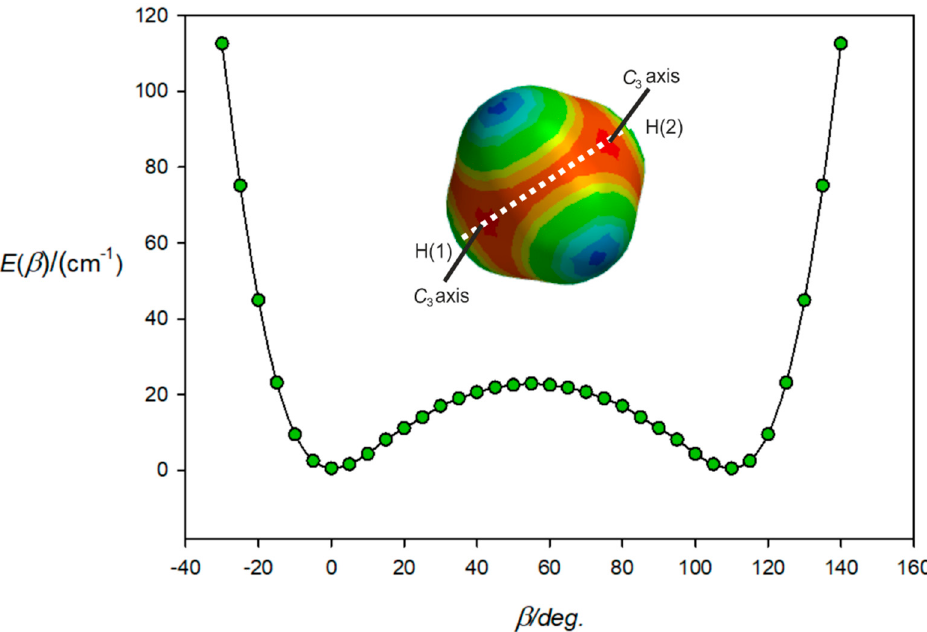
Figure 4. Variation of the energy of H 4 C ··· ClF with the angle β made by the ClF subunit with the C atom of CH 4 and when ClF lies in the H(1)-C-H(2) plane. At β = 0°, ClF lies along a C 3 axis and at β = 54.7°, lies along the C 2 axis associated with the edge between atoms H(3) and H(4). At β = 109.47°, ClF lies along the other C 3 axis indicated. As β further increases, the energy rises until the H(2) atom is encountered.